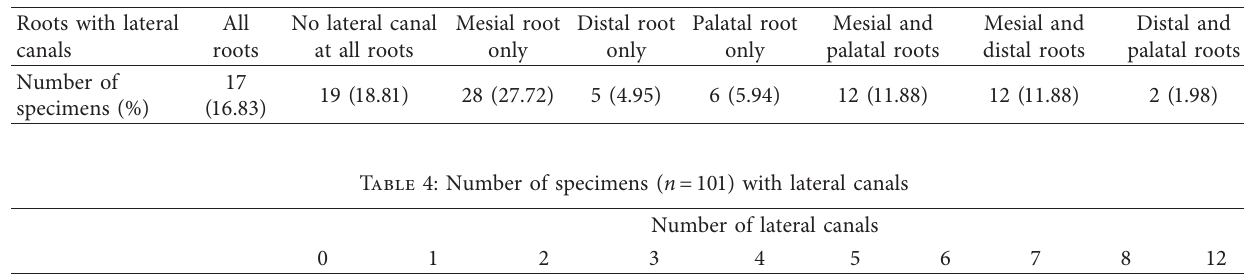
Table 3: Number of specimens ( n � 101) with lateral canals in roots